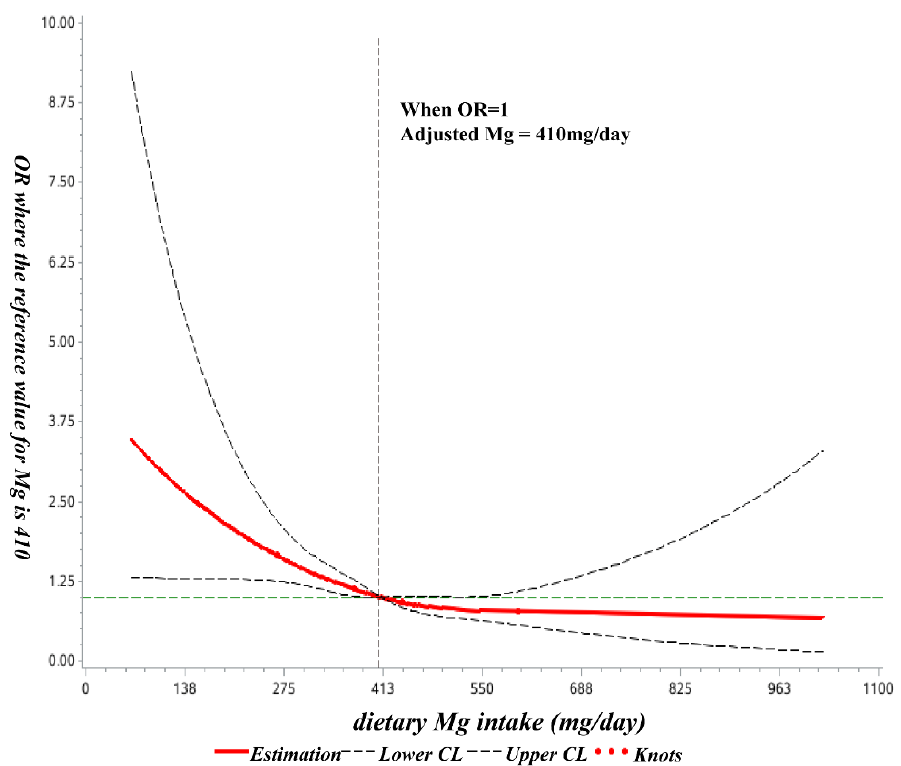
Figure 2. Dose-response relationship of dietary Mg intake with prediabetes OR. The ORs (solid lines) and 95% CIs (dashed lines) of dietary magnesium intake are indicated by straight lines based on restrictive cubic splines (RCS). Age, education, region, residence, SBP, DBP, BMI, waist circumference, TG, TC, HDL-C, LDL-C, UA, and dietary calcium intake were adjusted.